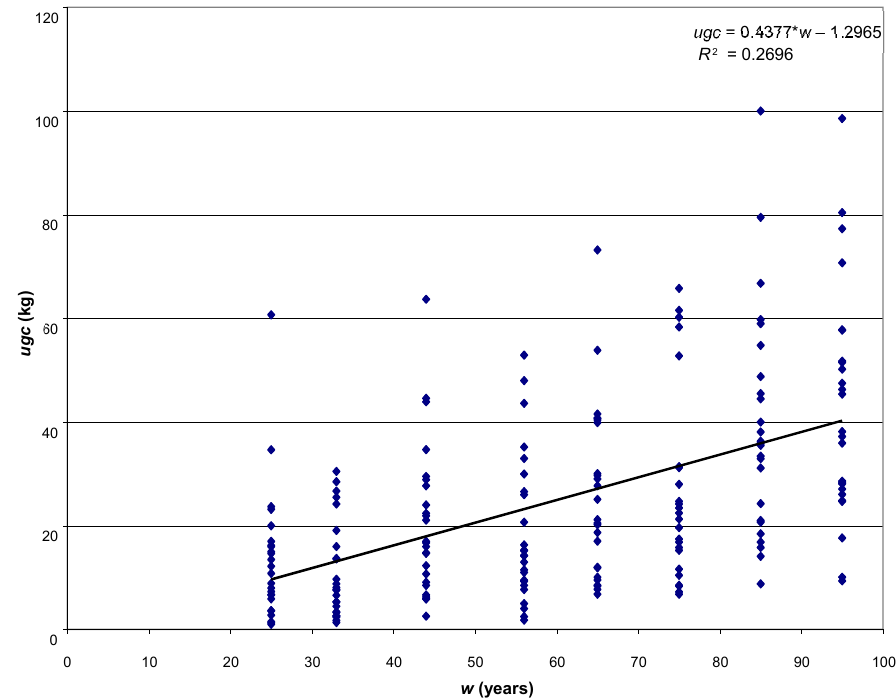
Figure 1. Dependence of weight of leaved twigs ( ugc ) on age ( w ).